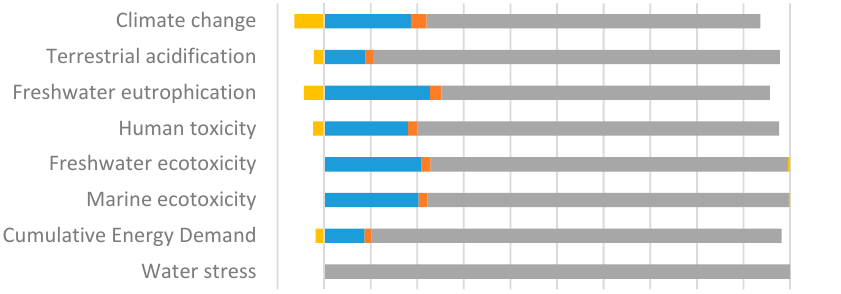
Figure 2. Relative contribution of each life cycle phase to characterized environmental impacts of the reference HYSOL plant.